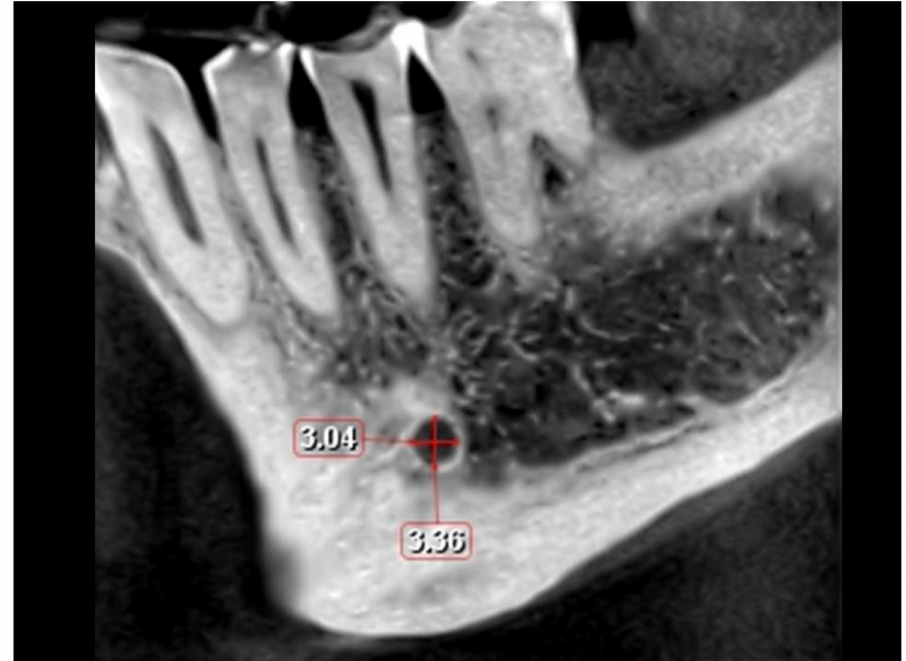
Figure 1. Height and length of the mental foramen (sagittal view).